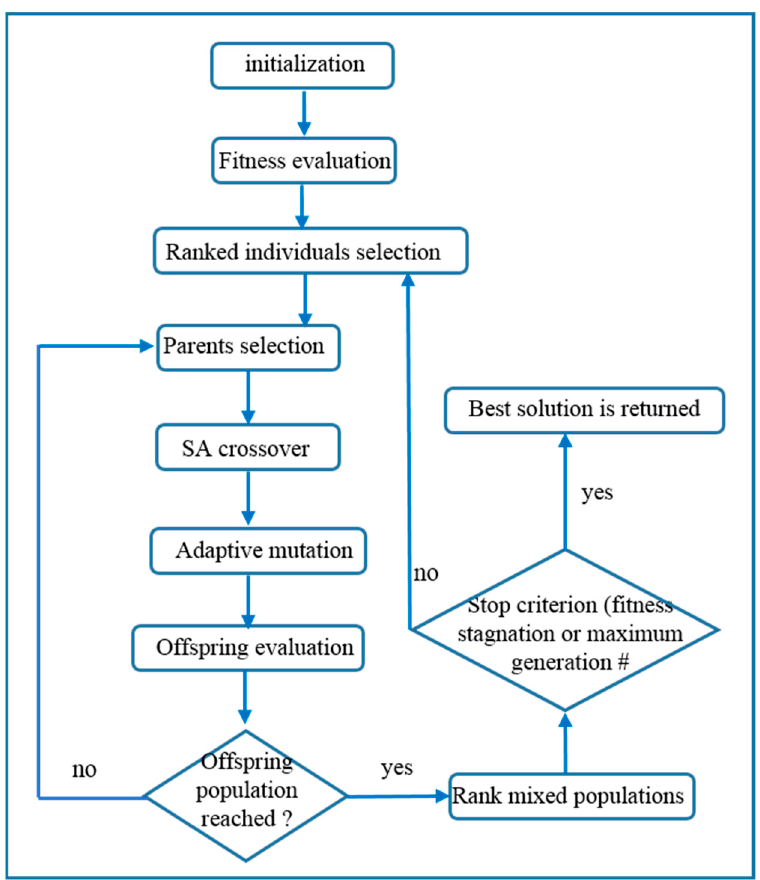
Figure 4. Basic flowchart of the NSGA ‐ II algorithm.